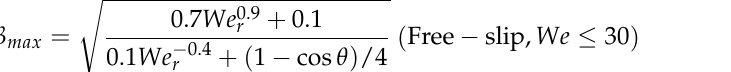
Figure 14. Correlation between the normalized droplet equivalent height R e = h e / D max and revised Weber number We r with R 2 =